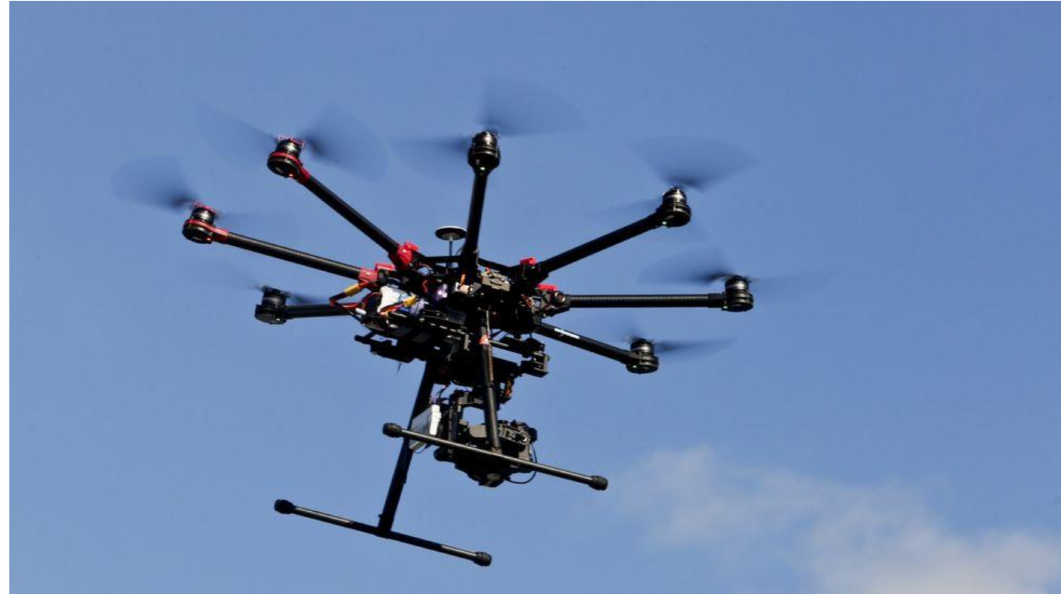
Figure 1. Drone for surveillance missions equipped with camera, GPS, and TV emitter.